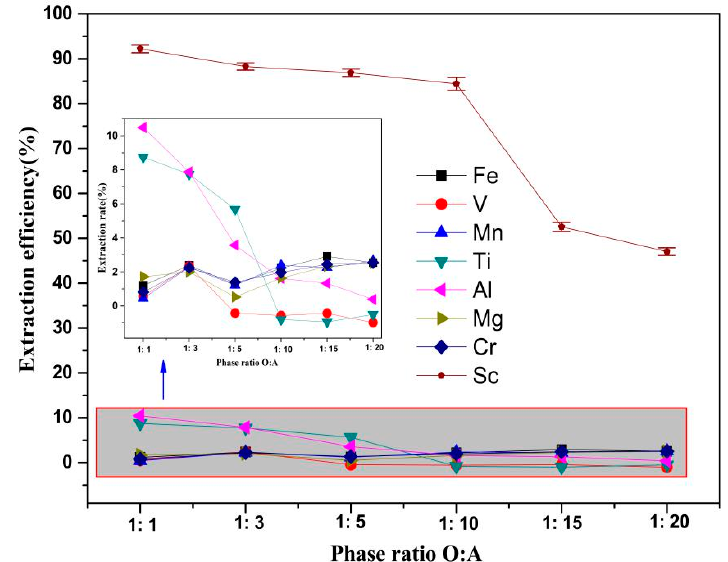
Figure 5. E ff ect of the O / A phase ratio on the Sc extraction (8% of D2EHPA, 2% of TBP, pH = − 0.75, Figure 5. Effect of the O/A phase ratio on the Sc extraction (8% of D2EHPA, 2% of TBP, pH = − 0.75, 5 5 min, at 298 min, at 298 K).